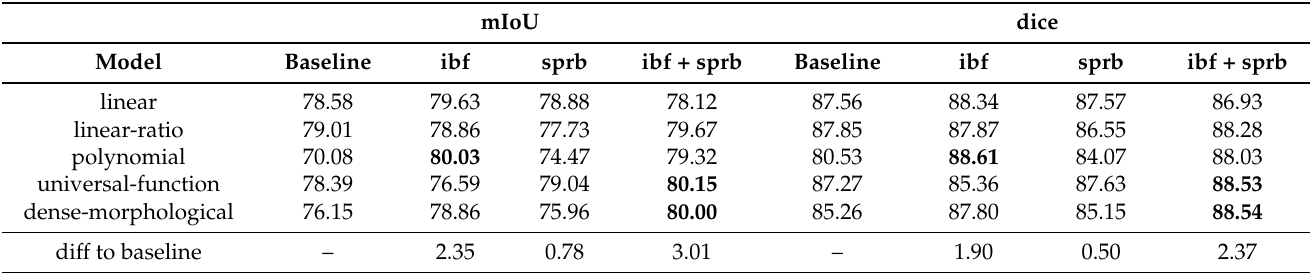
Table 3. Scores of DeepIndices with/without ibf and sprb for a kernel size of